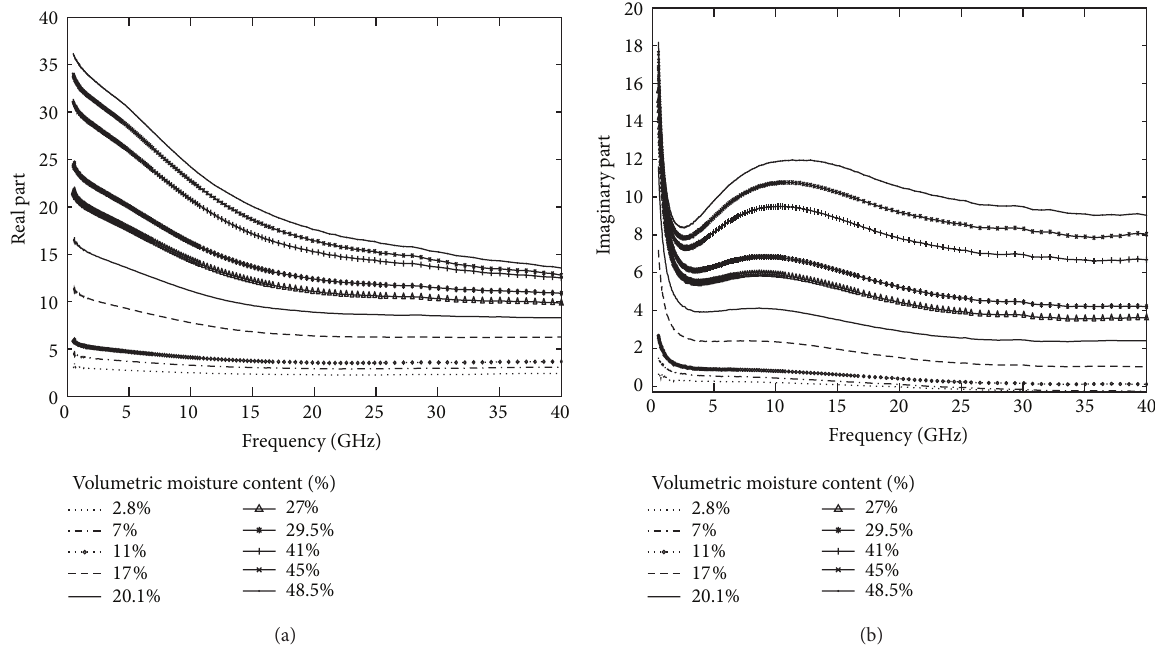
Figure 7: Frequency variations of the real (a) and imaginary (b) parts of the dielectric constant of the sample derived from laboratory measurements at different moisture content